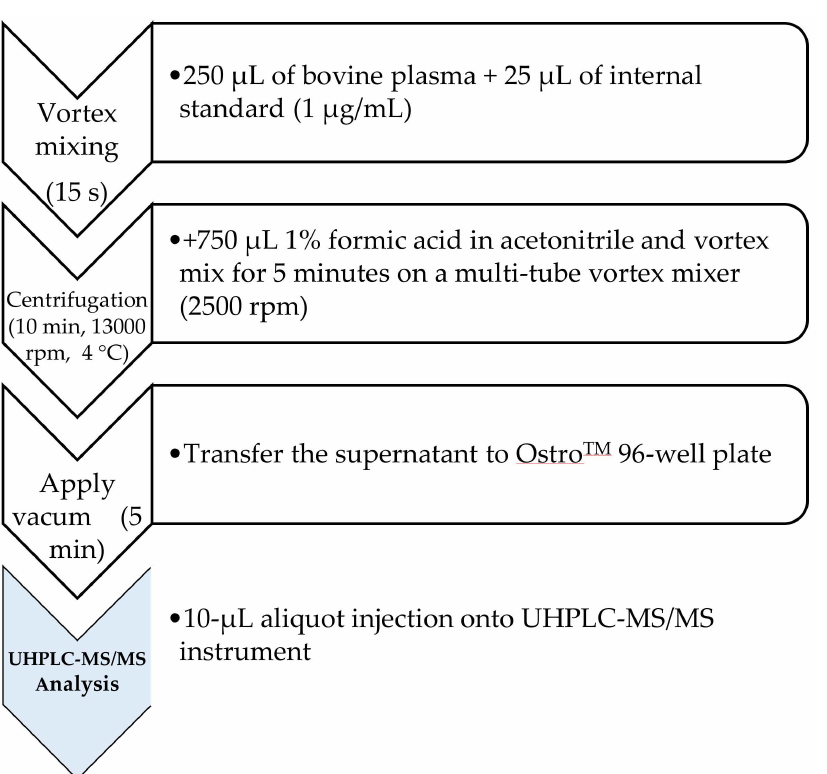
Figure 1. Schematical overview of the final sample preparation procedure for quantification of ivermectin (IVER), doramectin (DORA), moxidectin (MOXI) in bovine